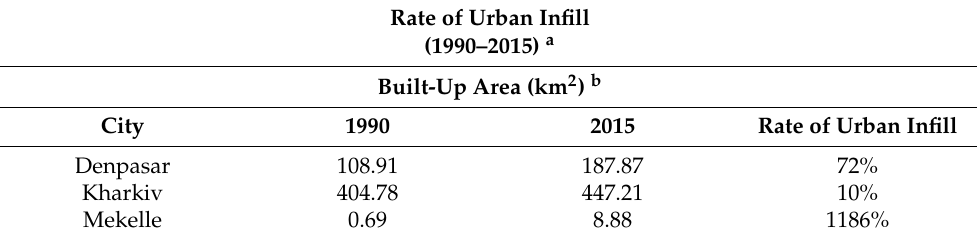
Table 6. Rate of urban